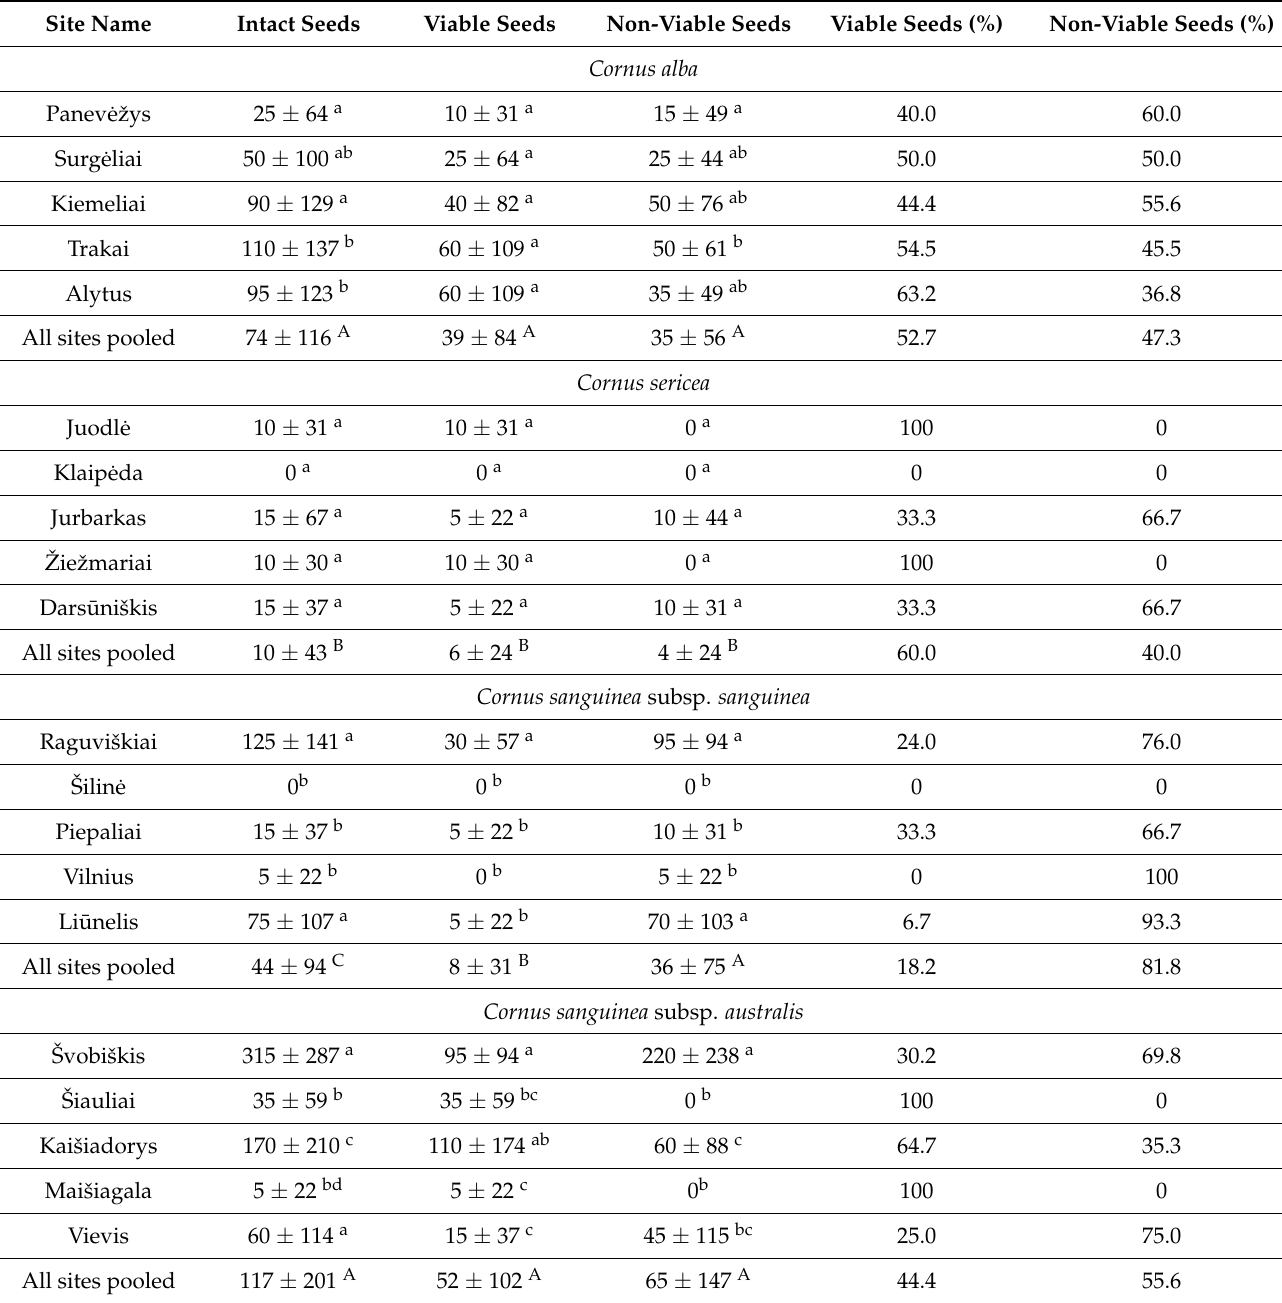
Table 6. Mean density of intact, viable and non-viable seeds (mean ± SD) per 1 m − 2 and percentage of viable and non-viable seeds in the lower soil layer (5–10 cm) of individual sites and all sites pooled of the studied Cornus taxa. Different lower-case and capital letters denote statistically significant differences between the means among the sites and taxa, respectively, applying Dunn’s post hoc